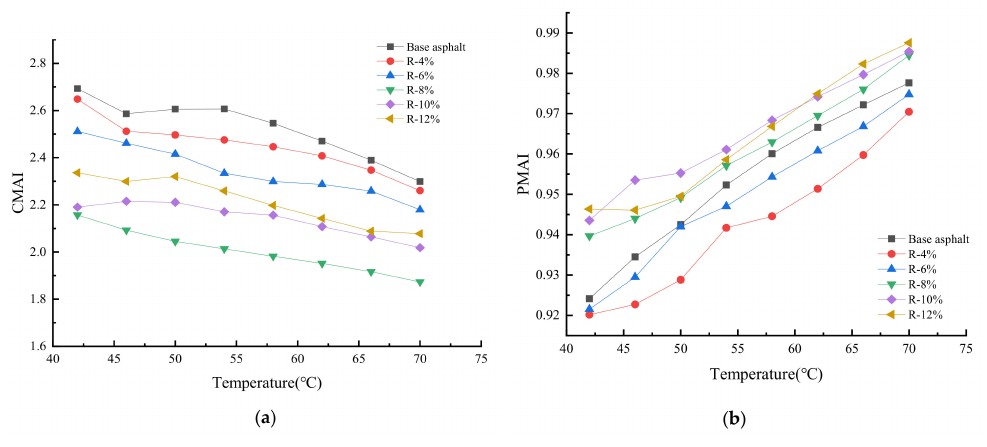
Figure 10. UV aging resistance of reclaimed asphalt after the UV aging. ( a ) CMAI. ( b ) PMAI.